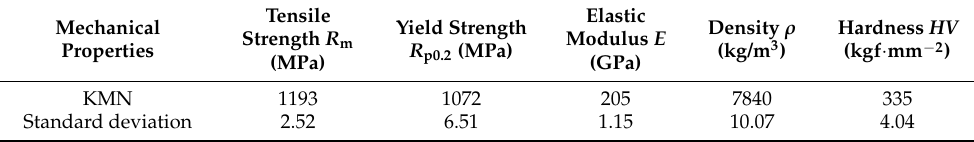
Table 1. Mechanical properties of KMN.